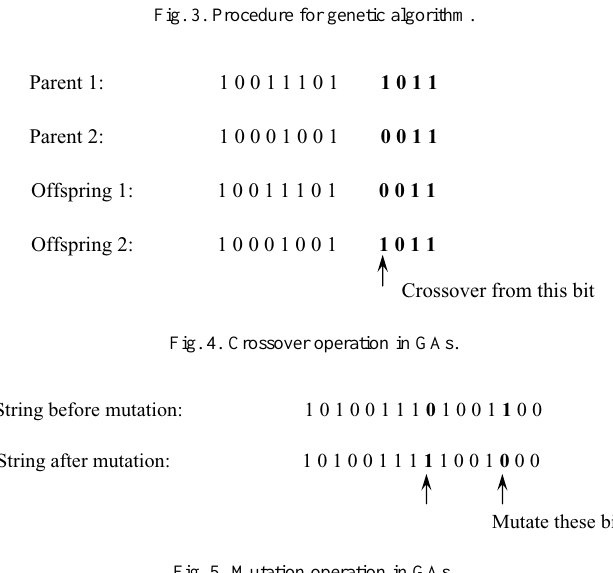
Fig. 4. Crossover operation in GAs.